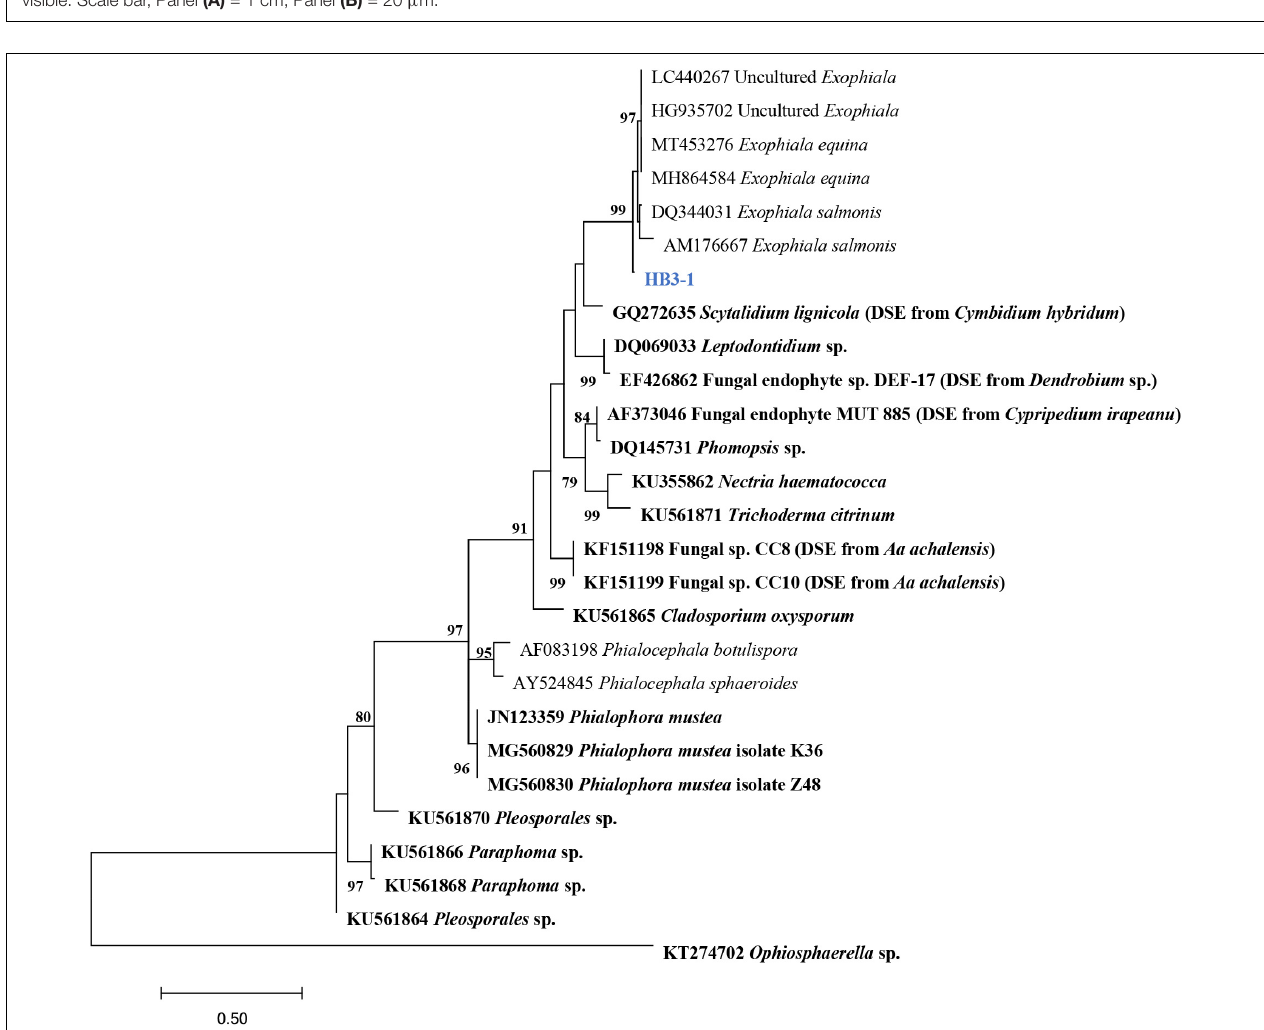
Frontiers in Microbiology |